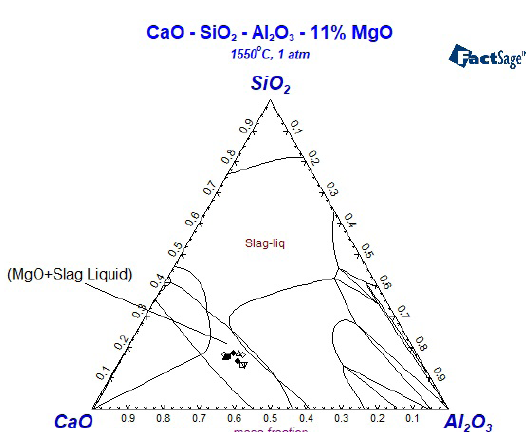
Figure 2. Measured data of refining slags from different industrial heats.